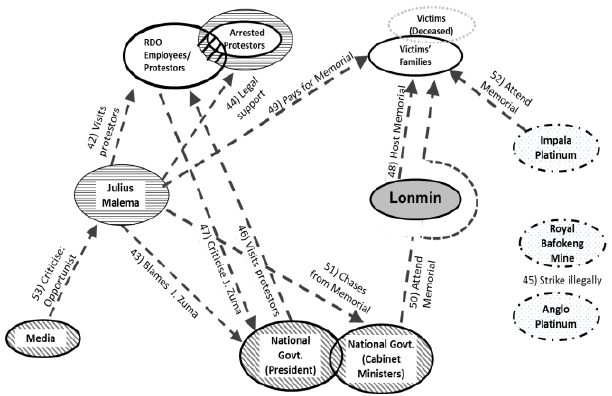
Figure 8: Stakeholder model for other stakeholders (Period 17 to 24